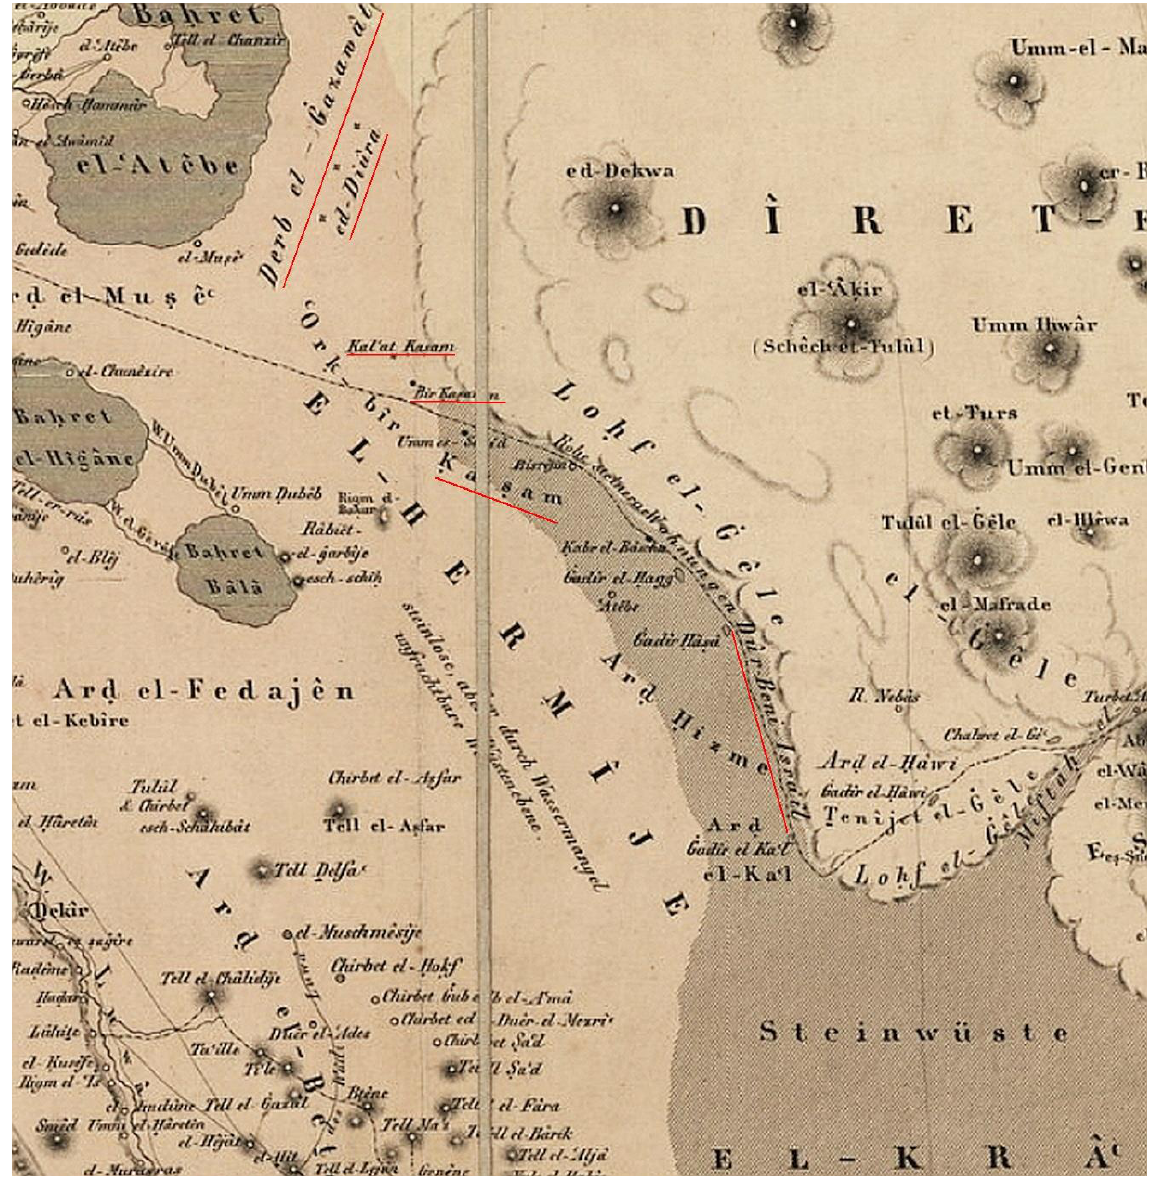
Figure 6: Detail of H. Kiepert 1860s map, according to J.G. Wetzstein’s travels 1858, M1: 400000 102